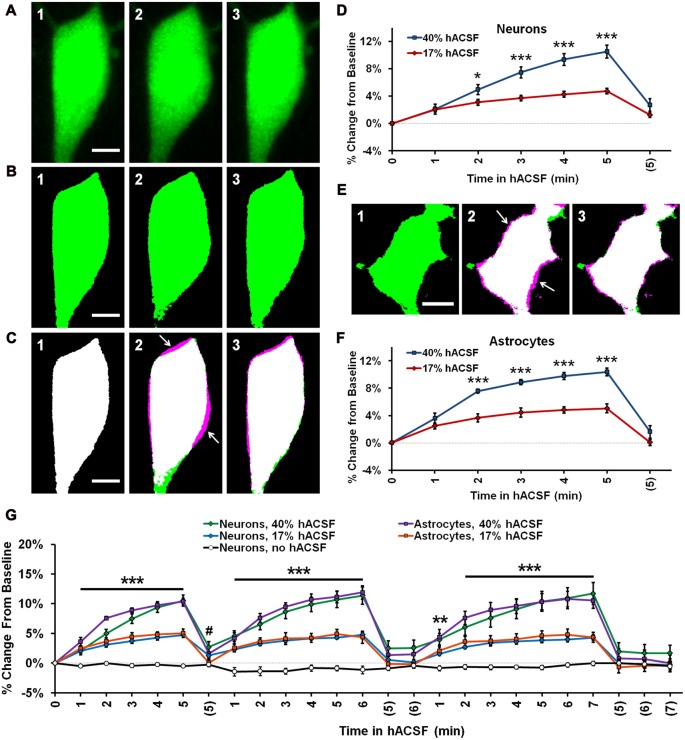
Neurons and astrocytes both swell in hypoosmolar conditions. (A) Representative MIPs of a CA1 pyramidal neuron loaded with Alexa Fluor 488 dye via patch clamp, depicting soma volume at baseline (A1), followed by 5 min in 40% hACSF (A2), and a subsequent 5 min wash period in nACSF (A3). Swelling of the soma during hACSF application is readily apparent in (A2). (B1–B3) Time points in (A1–A3) are processed and binarized (see Figure 1) to allow measurement of soma area. Images are pseudocolored green for easier comparison with (A). (C) Each thresholded image in (B) is pseudocolored magenta and overlaid with green baseline image from (B) to reveal regions of soma expansion during 40% hACSF, which recover to near basal levels upon return to nACSF (magenta highlights, indicated by white arrows). Scale bars = 5 μm. (D) Quantification of neuronal soma volume as a percent change from baseline area in 17% and 40% hACSF conditions over a single 5-min application, followed by a 5 min wash period denoted with (5). Time points 0, 5 and (5) correspond to images in (A1–A3) respectively. (E) Representative thresholded images of an astrocyte loaded with Alexa Fluor 488 dextran (10,000 MW) at baseline (E1), after 5 min in 40% hACSF (E2), and after a 5 min wash in nACSF (E3). As in (A), images in (E2,E3) have been overlaid with the baseline image to illustrate changes in cell volume (white arrows). Scale bar = 5 μm. (F) Quantification of astrocyte soma volume as a percent change from baseline area in 17% and 40% hACSF conditions. *p < 0.05 and ***p < 0.001 for 17% vs. 40% at each time point in (D,F). All time points for both 17% and 40% hACSF were significantly elevated over baseline. (G) Expanded time course showing neuron and astrocyte volume changes over multiple re-applications of 40% or 17% hACSF. Neuron volume in control conditions (“no hACSF”, black line) is included for comparison. ***p < 0.001, **p < 0.01 (both cell types) and #p < 0.05 (astrocytes only), percent change vs. 0% (baseline). N = 7–9 cells per hACSF group and six cells for control.